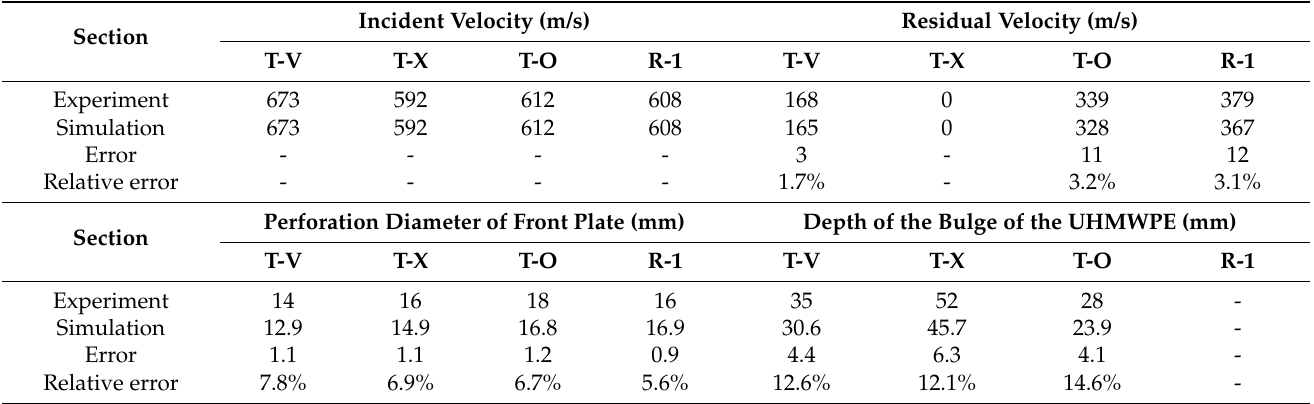
Figure 8. The relative error of simulation and ballistic tests. ( a ) Residual velocity. ( b ) Perforation diameter of the front plate. ( c ) Depth of the bulge on the laminate. Table 7. Comparison of ballistic test results with numerical simulation